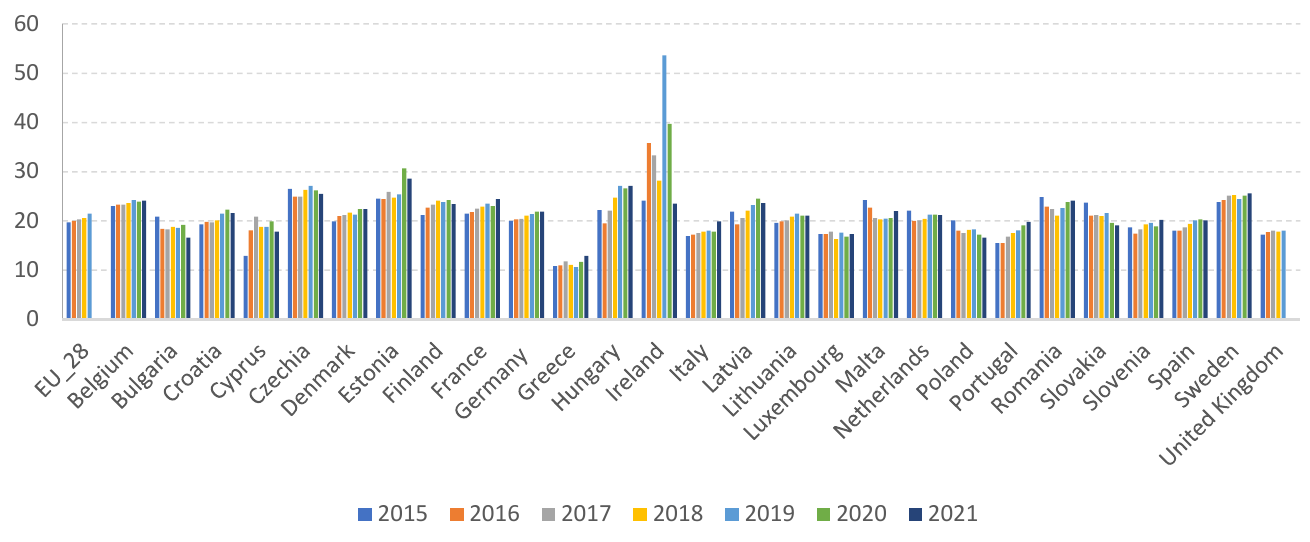
Figure A1. Gross fixed capital formation in relation to GDP in EU countries, 2015–2021. Source: own elaboration based on [45].